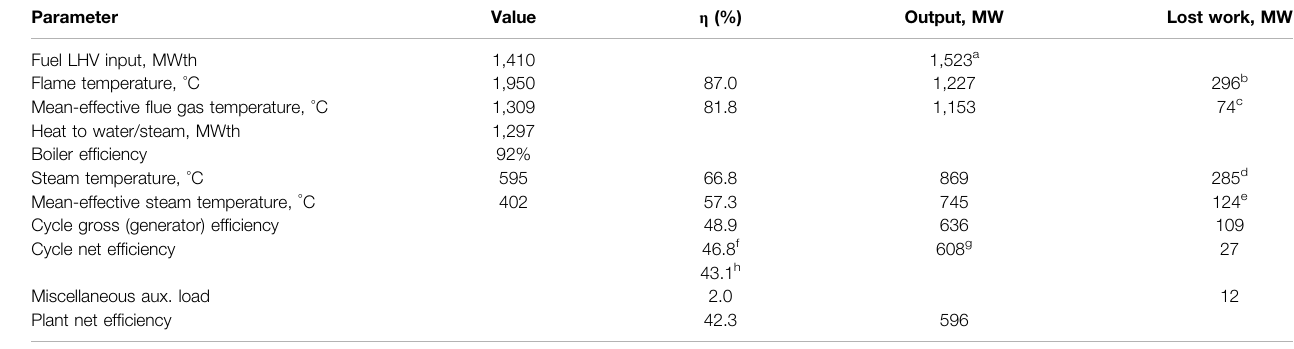
TABLE 1 | Steam cycle